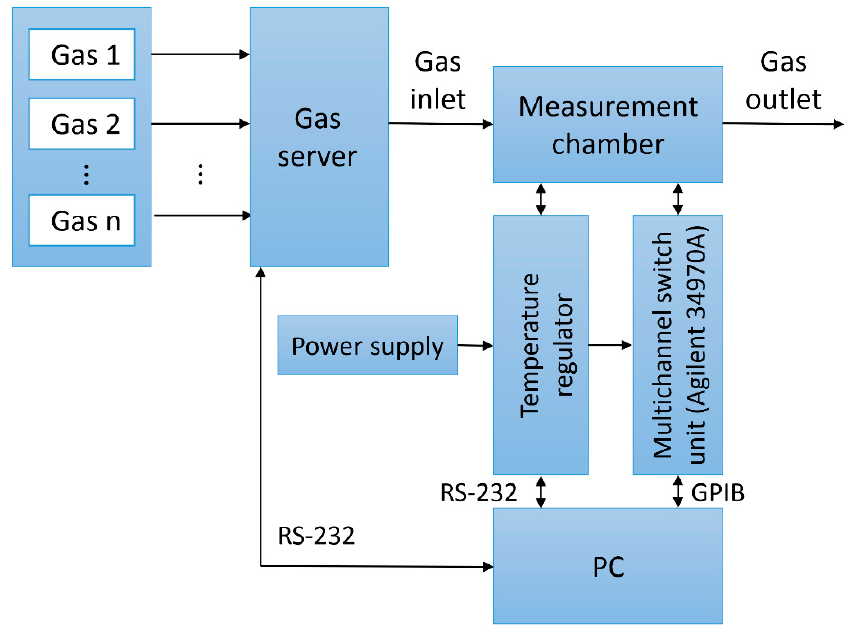
Figure 2. The scheme of the gas measuring system.